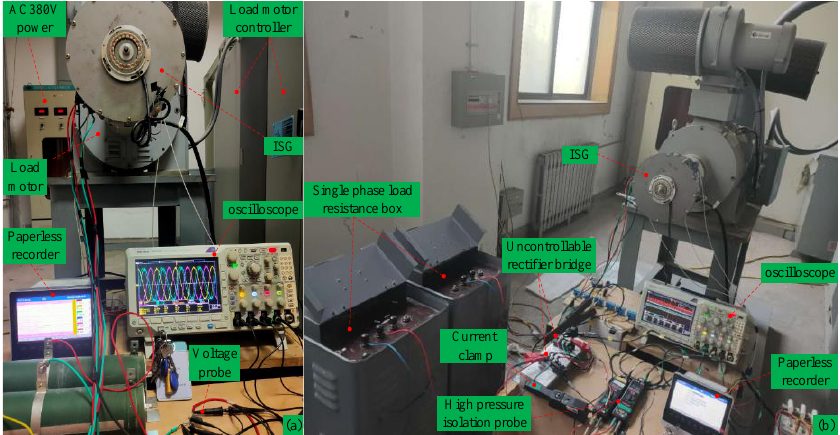
Figure 25. Test platform of power generation mode. ( a ) No-load test, ( b ) load test of two groups of 65 Ω load resistance.